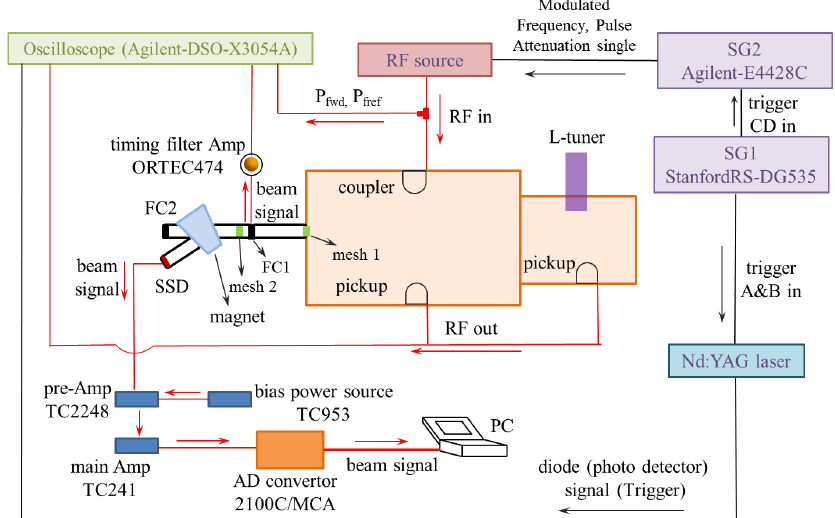
FIG. 11. Layout of the beam acceleration system.